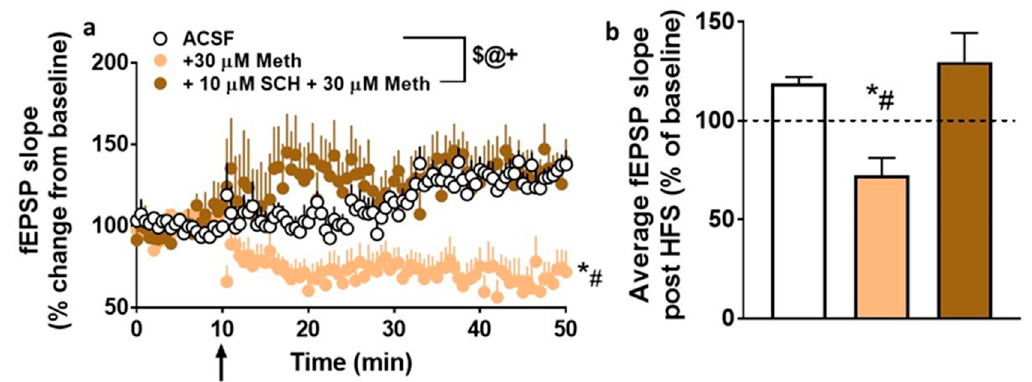
Figure 6. Ex vivo methamphetamine exposure reduces long-term potentiation (LTP) in dorsomedial striatal synapses. ( a ) xy graph of time course of fEPSPs before and after high-frequency stimulation (HFS) in all groups. The arrow in ( a ) at 10 min points to the time of HFS. ( b ) Average fEPSP slope of each experimental group post HFS (10 to 50 min). Data are represented as mean ± SEM. n = 8 control slices, n = 8 methamphetamine slices, n = 5 SCH23390 + methamphetamine slices. $ p < 0.05 significant interaction; @ p < 0.05 main effect of time; + p < 0.05 main effect of treatment by repeated-measures two-way ANOVA; * p < 0.05 vs. controls; # p < 0.05 vs. SCH23390 + methamphetamine by Fisher’s LSD post hoc test.